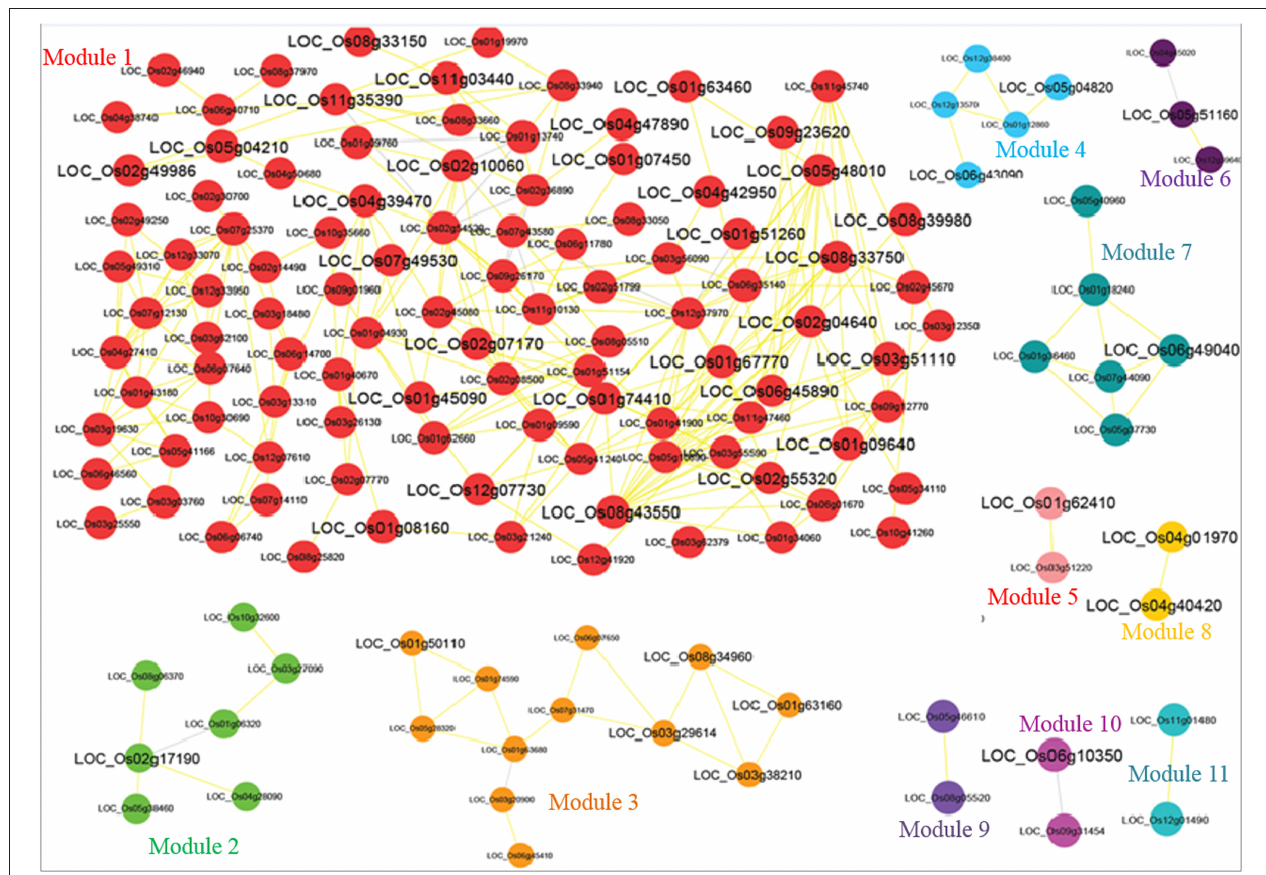
FIGURE 2 | Co-regulatory rice OsMYB network identified by top-down approach. The 11 modules are shown in different color. Fonts in larger size indicate differentially expressed OsMYBs . The positive and negative correlation value is shown by yellow and gray color edges, respectively.